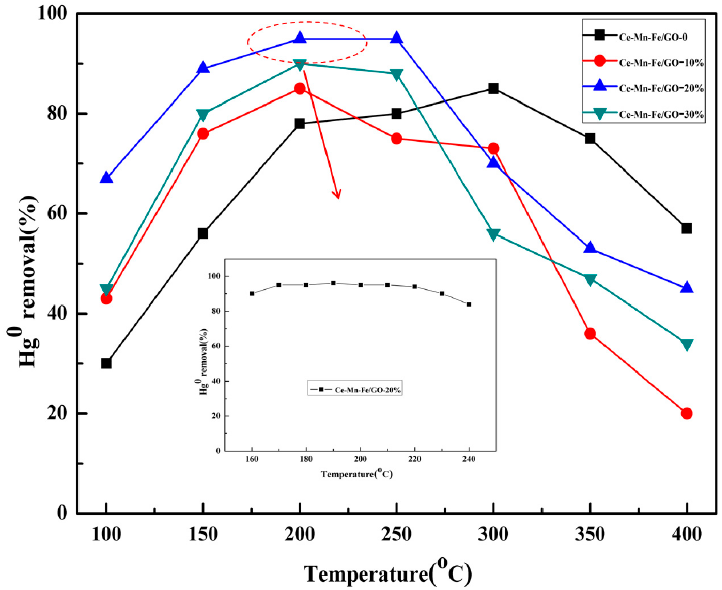
Figure 5. Hg 0 removal over Ce-Mn-Fe/GO-x (x = 0, 10%, 20%, 30%) catalysts at different temperatures (Flue gas conditions: 6% O 2 , 600 ppm SO 2 , 800 ppm nitrogen oxide (NO), N 2 as balance gas).